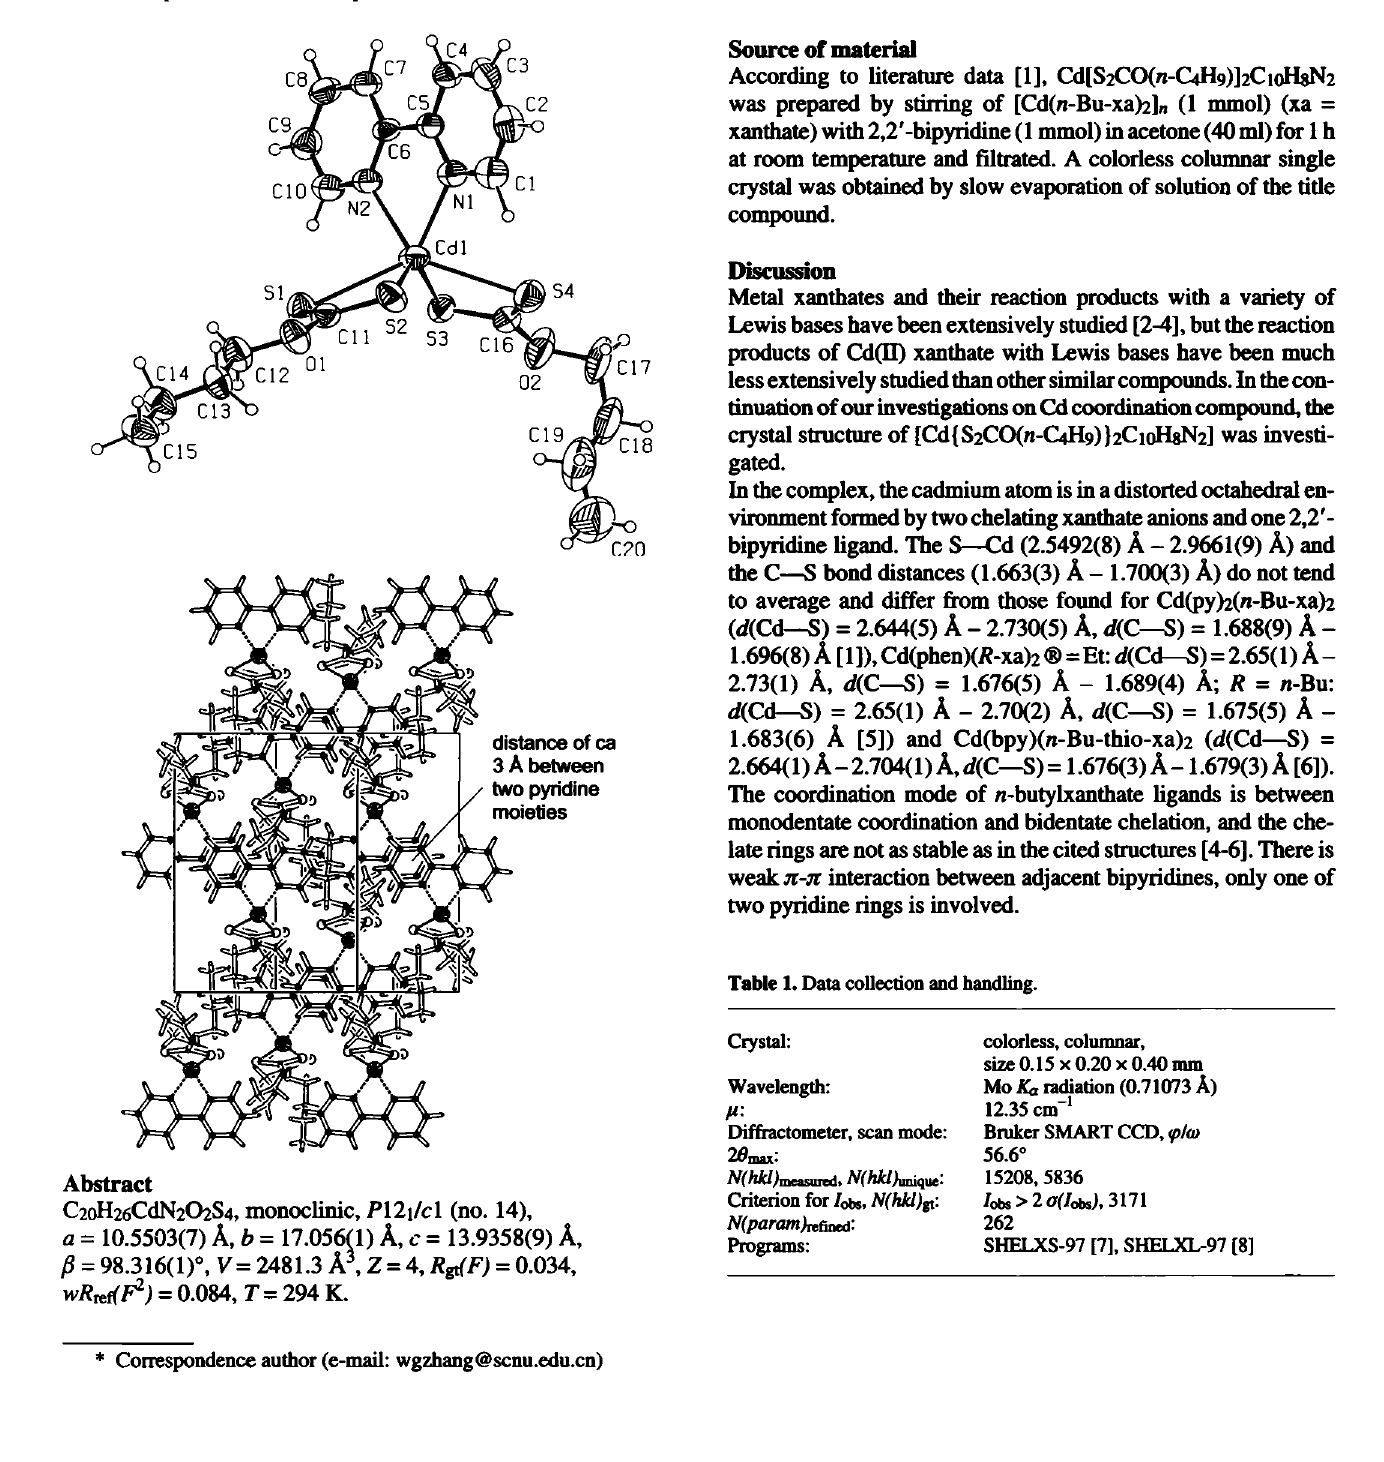
wRtdF 2 ) = 0.084, T= 294 K.